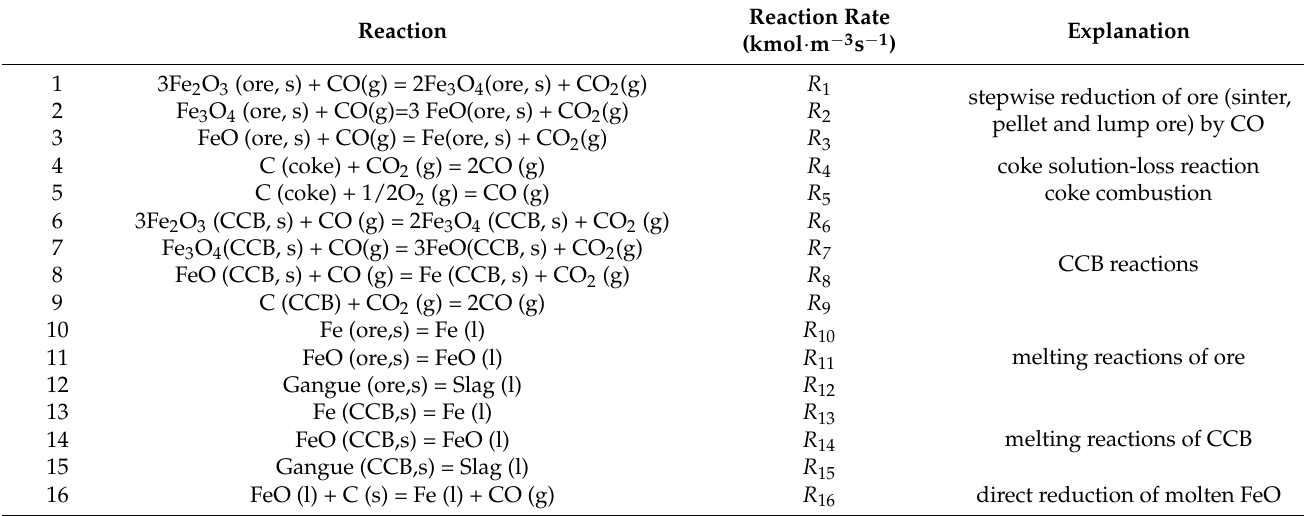
Figure 1. Mesh placement for numerical simulation. Table 3. Equations involved in BF